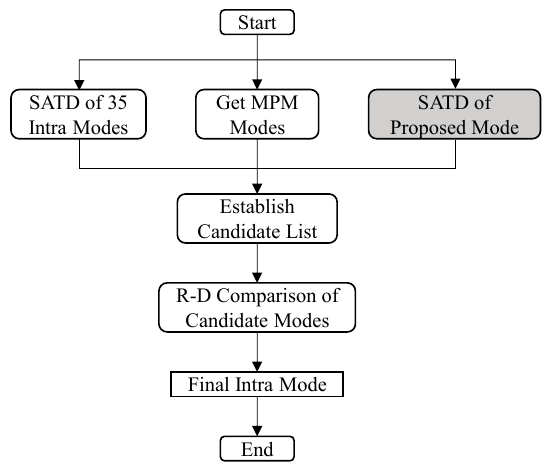
Figure 5. Illustration of the luma mode derivation.